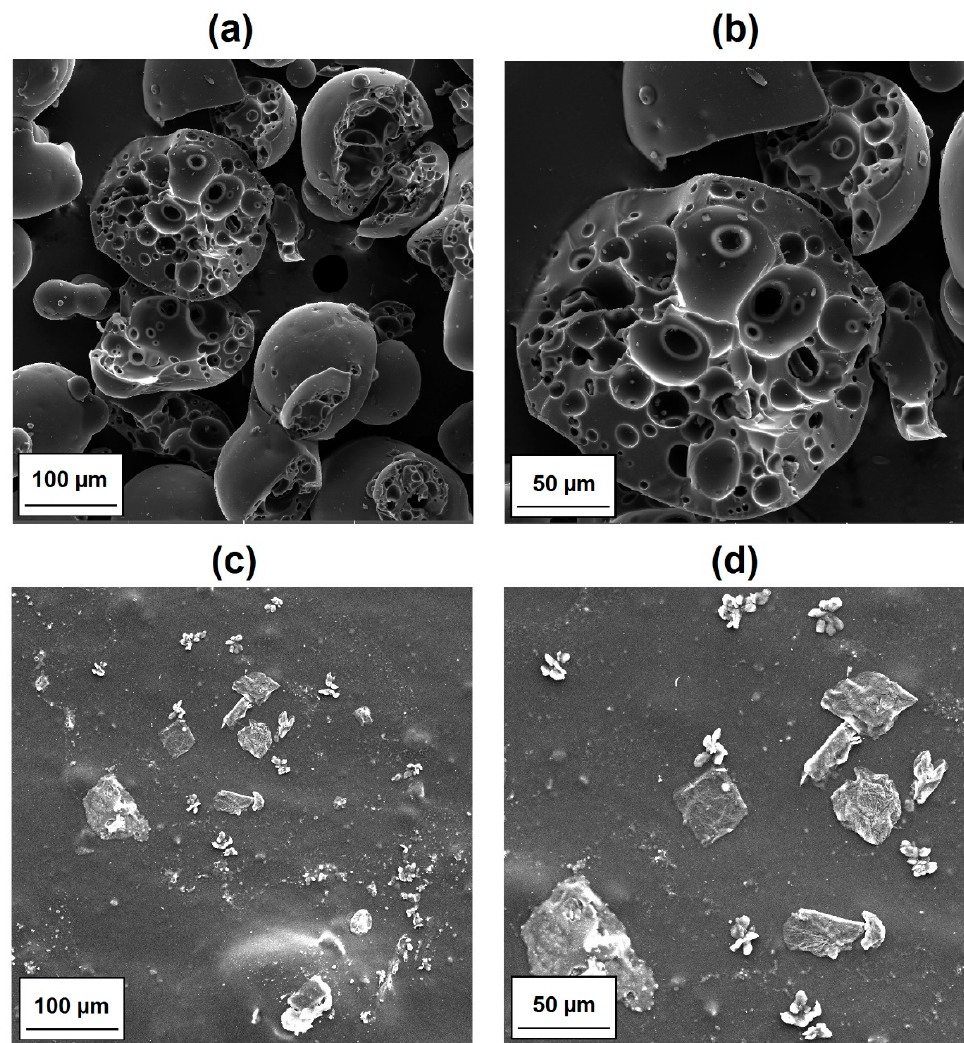
Figure 5. Representative SEM images of ( a , b ) lignin filler particles and ( c , d ) LDPE/lignin composite films.